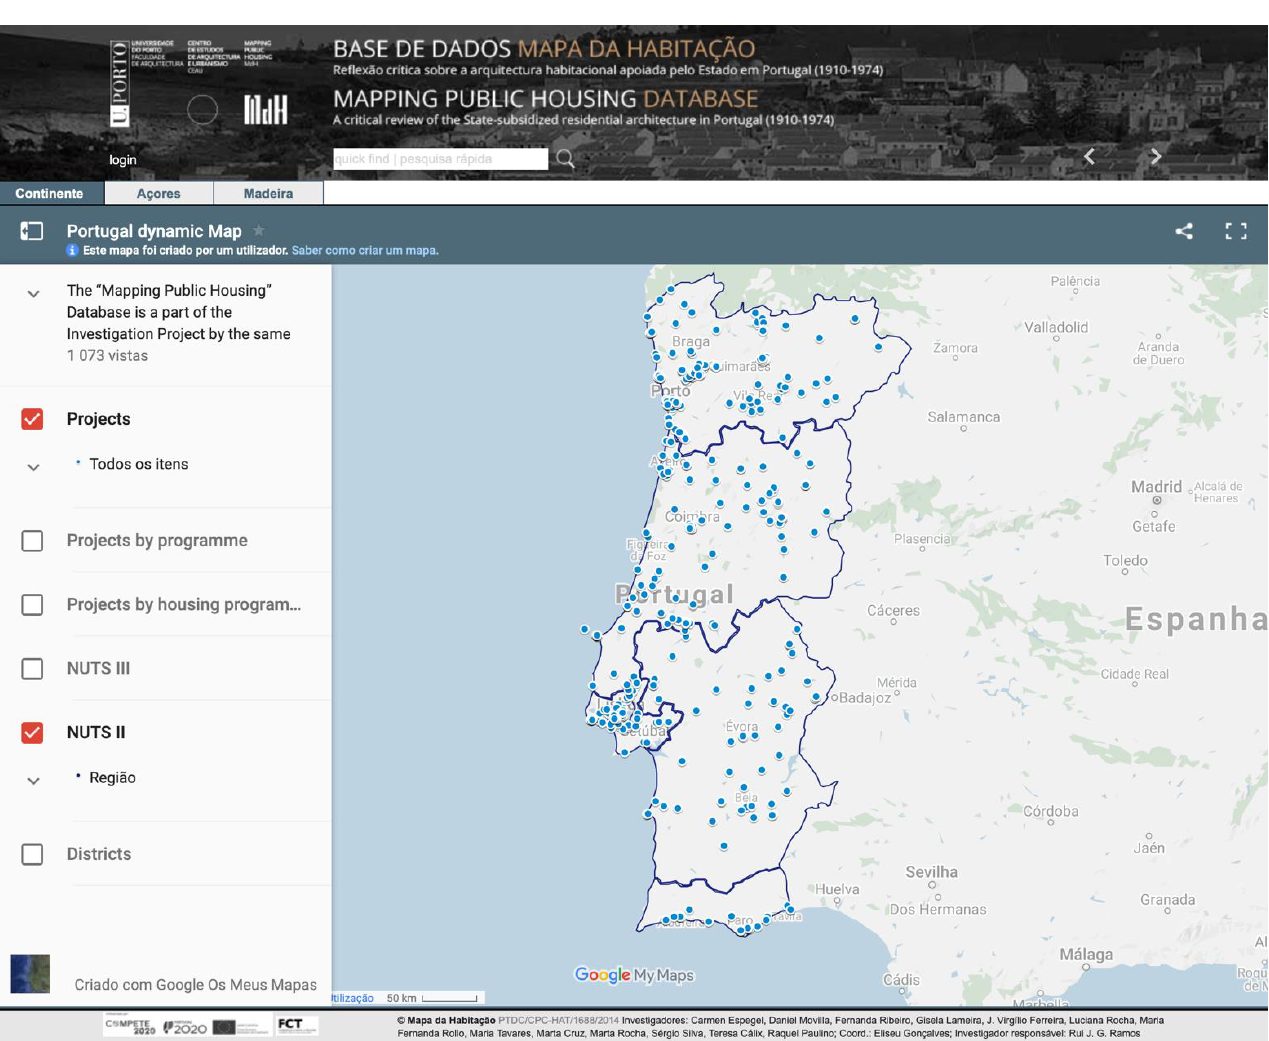
Figure A4. Linear chart. Distribution of housing descriptors per year. Source: MdH database, 2019. Universe: built estates and phases included in MdH between 1910 and 1974, and number of dwellings. Error factors: in some cases, the number of dwellings is an estimate; the reference date is the first known date; in the case of large urban plans—such as Olivais Norte, Olivais Sul and Chelas—the values entered are the date of the plan and the projected number of dwellings (sep- arate parts of these are not considered in the graphs and are recorded in the database due to their architectural relevance). Data conditions: Omit records—Type promotion: (= Privada: Rendimento Imobiliário); Omit—Year web sort: (0 < 1910); Omit records—Year web sort: (>1974); Omit rec-ords—Build condition (=NC); Find records—Plan district building: (=bairro|district).